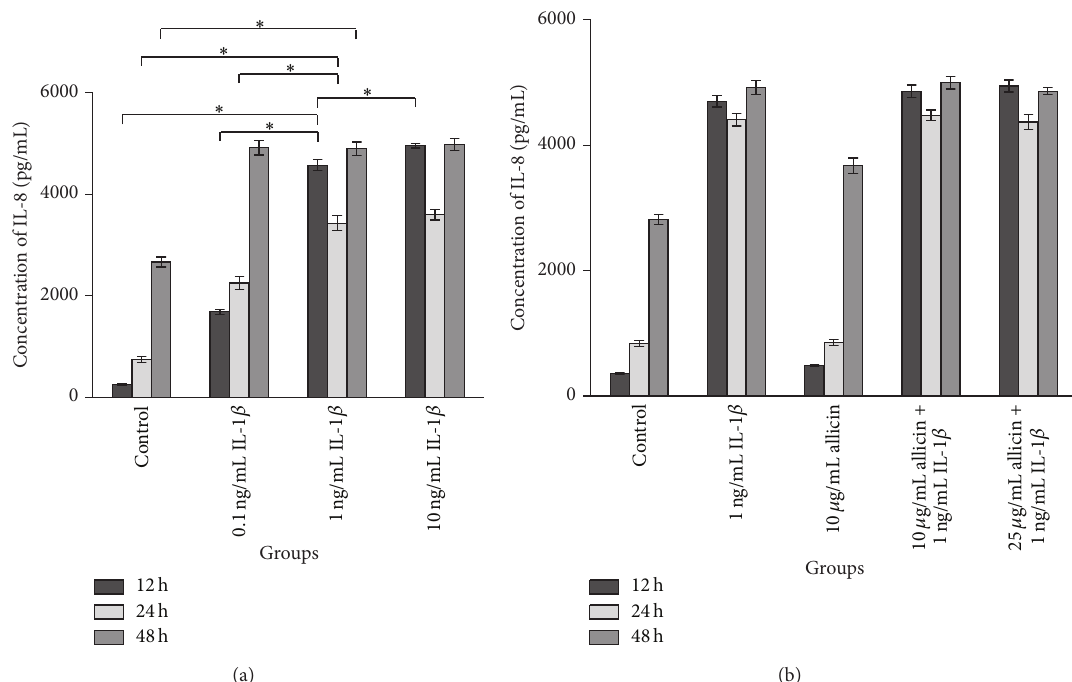
Figure 5: The influence of IL-1 𝛽 and allicin on IL-8 in the supernatant of Caco-2 cells. (a) 1ng/mL IL-1 𝛽 significantly increased concentrations of IL-8 in the medium of Caco-2 cells at 12 and 24h; (b) IL-8 level was not changed by allicin on IL-1 𝛽 -induced Caco-2